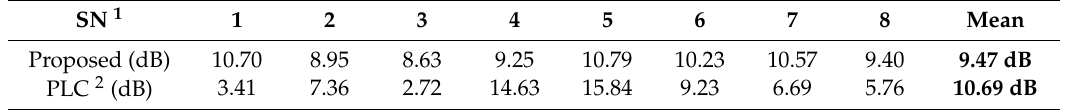
Table 3. RAIs of the real targets in red boxes.